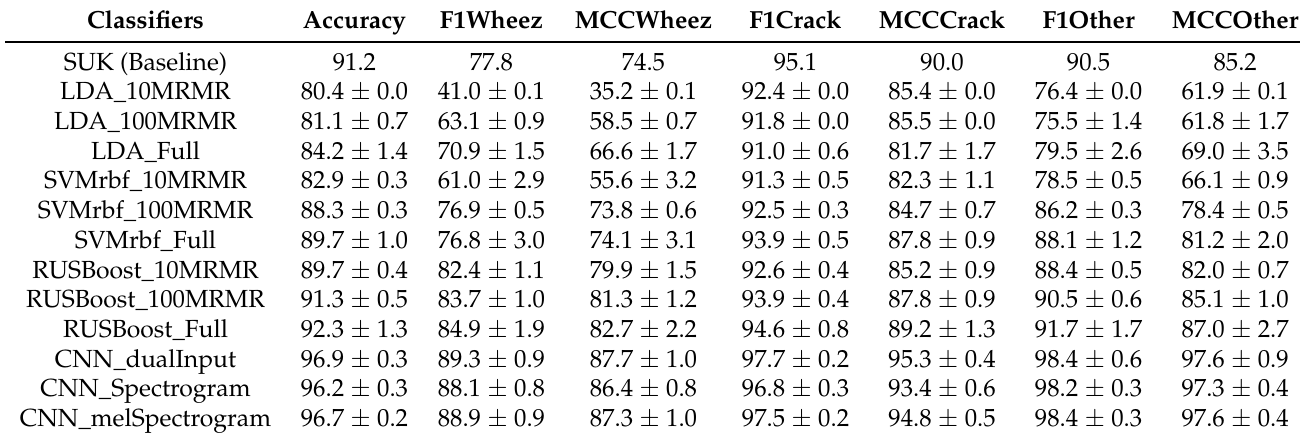
Table 8. Performance results obtained with 3 classes (crackle vs. wheeze vs. other)—training: fixed duration; testing: fixed duration.